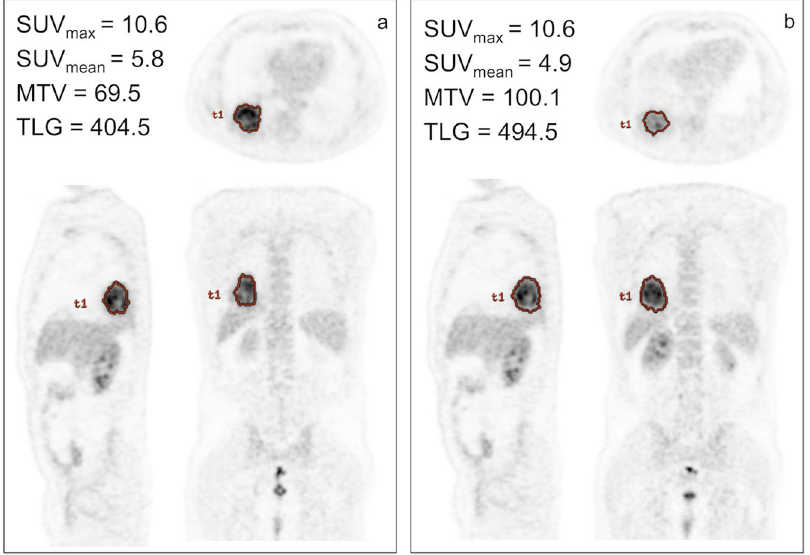
Figure 3. Example of tumor contouring using in ( a ) a threshold method at 50% of SUV max and ( b ) a method based on an absolute SUV cut-off of 2.5. The ROI identified by using the absolute SUV cut-off of 2.5 is greater than that identified by the threshold method, as shown by axial (top), sagittal (right), and coronal (left) images (same